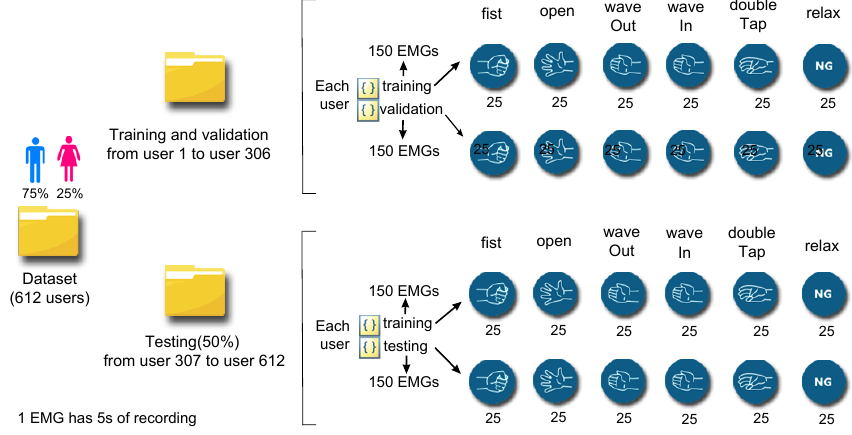
Figure 2. EMG-EPN-612 dataset. One model was trained for each user data point (user-specific